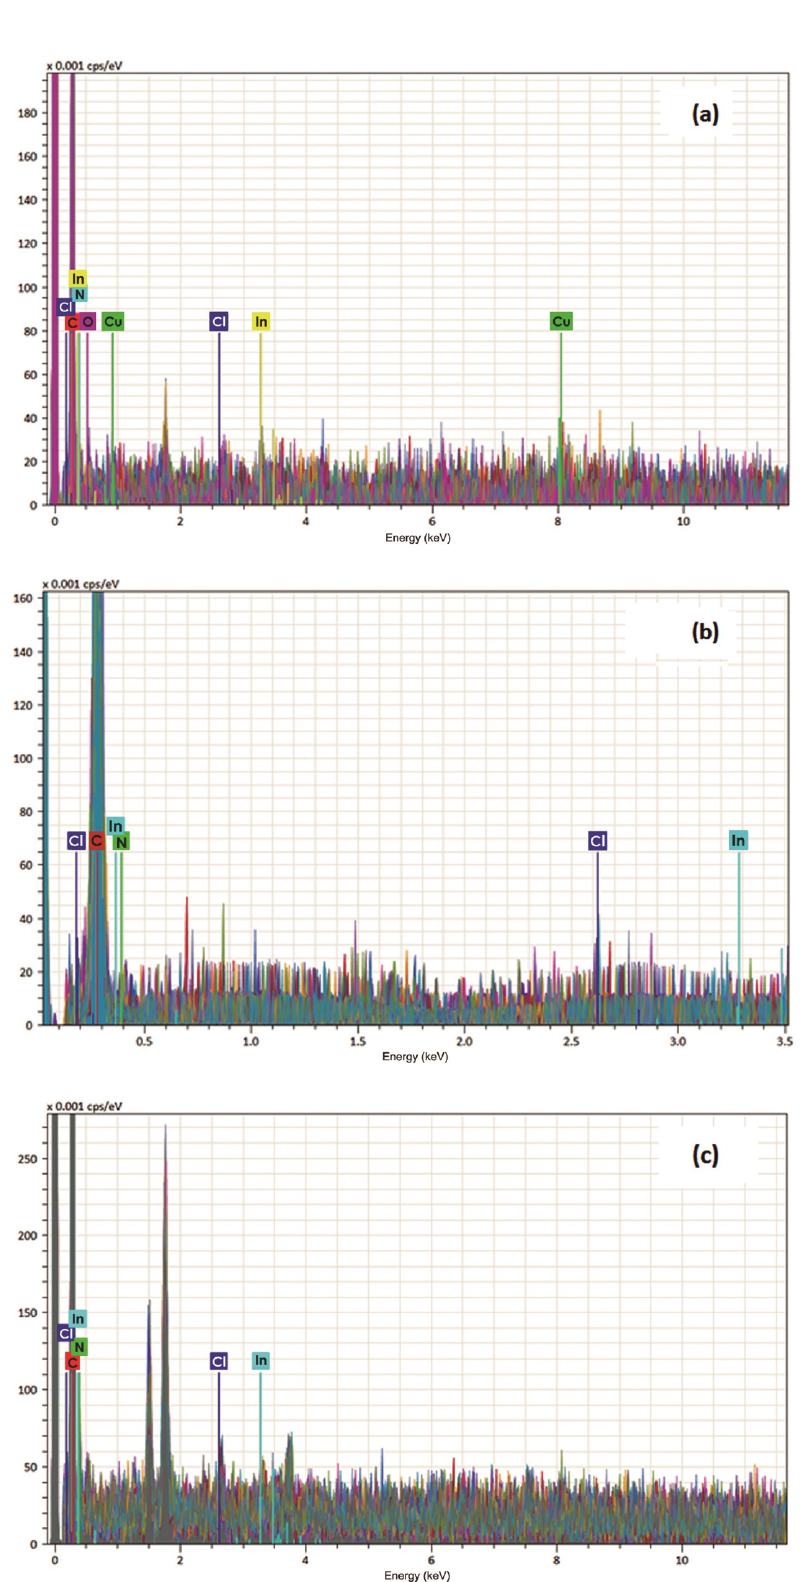
2 Figure 2. ( a ) S1 , ( b ) S2 and ( c ) S3